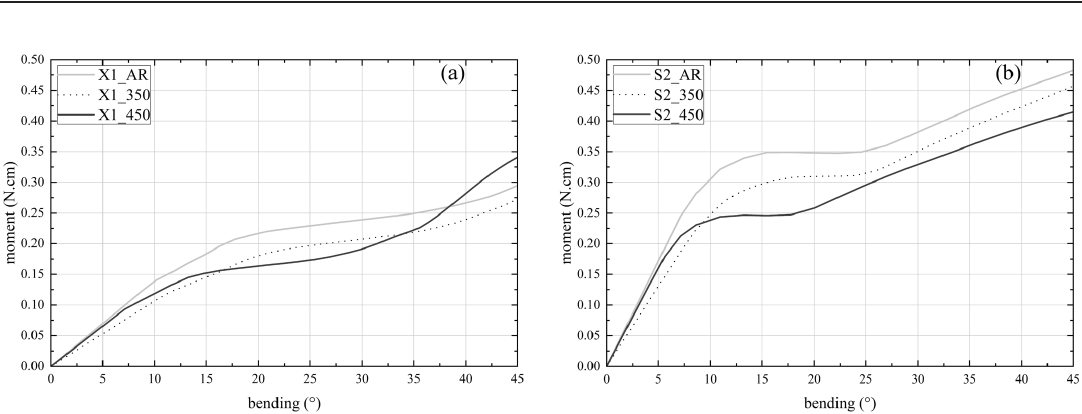
Figure 3. Numerical moment-bending curves: (a) X1 file and their respective heat treatment conditions and (b) S2 file and their respective heat treatment